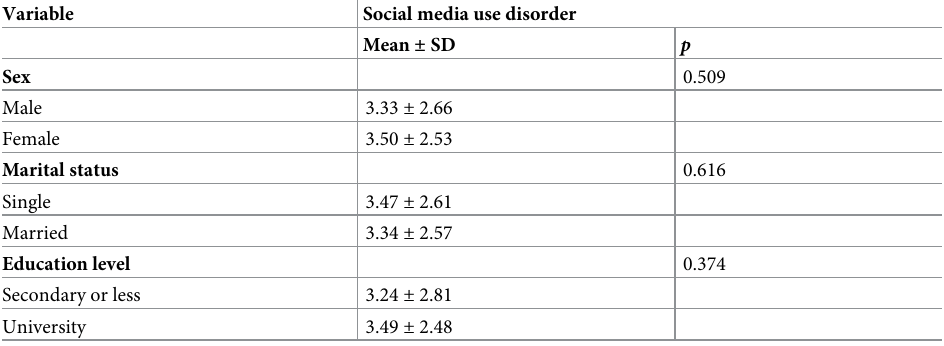
Table 3. Bivariate analysis of the categorical variables associated with social media use disorder